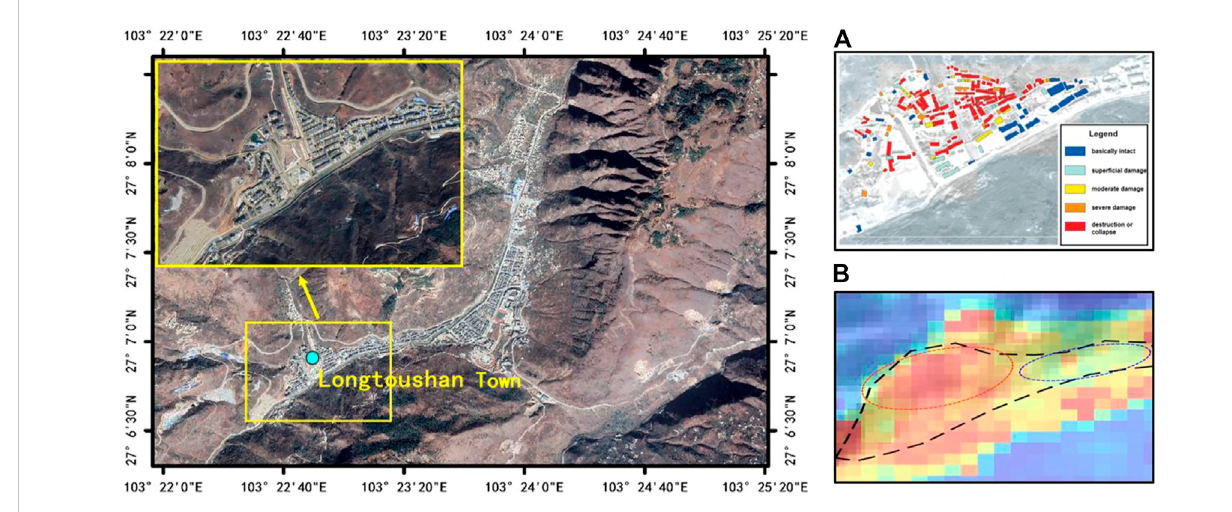
FIGURE 12 Comparison of the actual damage. (A) Spatial distribution of the seismic damage to buildings in Longtoushan Town Lin et al. (2020). (B) Local PGA map of Longtoushan Town, this study. The colour scale is the same as Figure